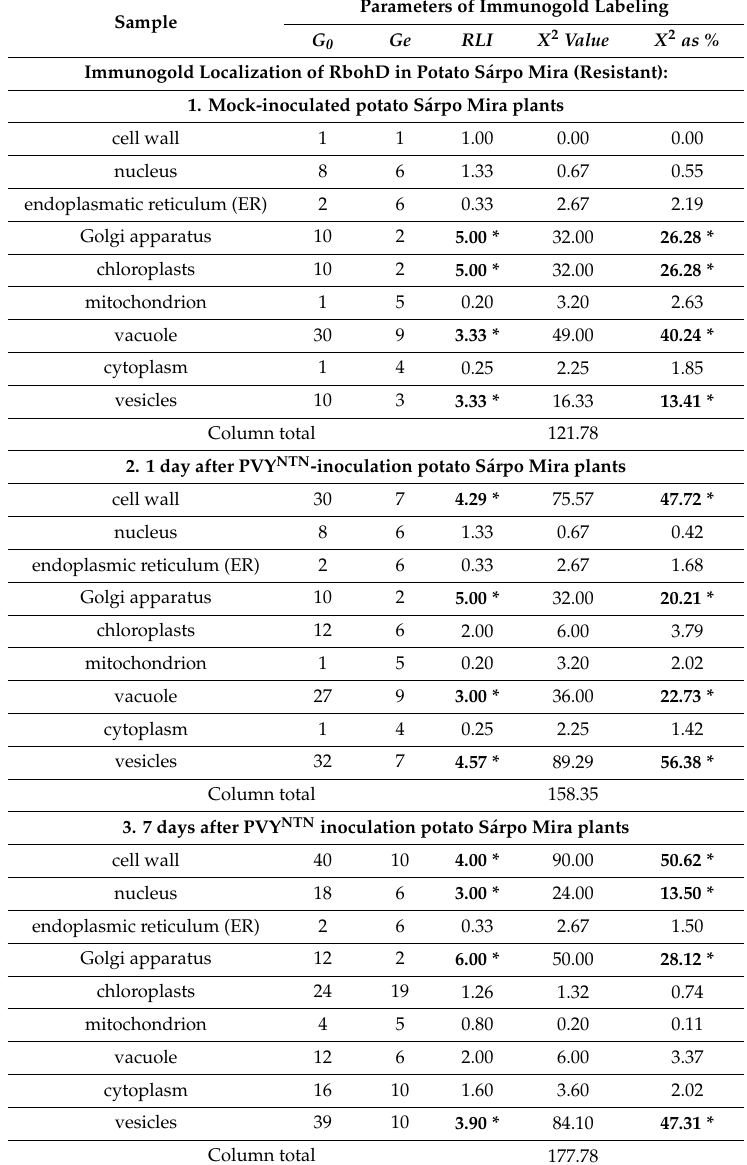
Table 1. Quantification of immunogold labeling of RbohD by Relative Labeling Index (RLI) and X 2 tests in mock-inoculated and PVY NTN -inoculated. S á rpo Mira (resistant) potato plants before hypersensitive reaction (HR) symptoms (1 dai) and after HR symptoms developed (7 dai). Significant values (RLI > 1, and % X 2 at least 10%) in bold font and marked with an